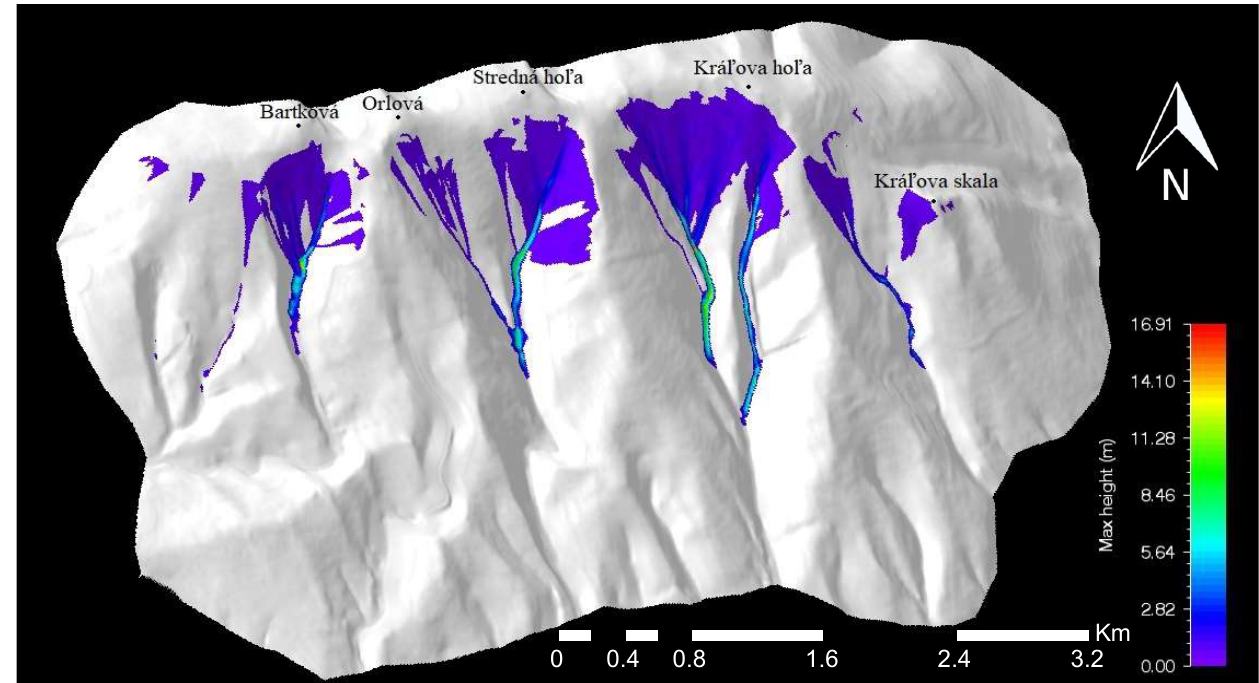
Figure 4. Maximum snow flow height (southern slope).